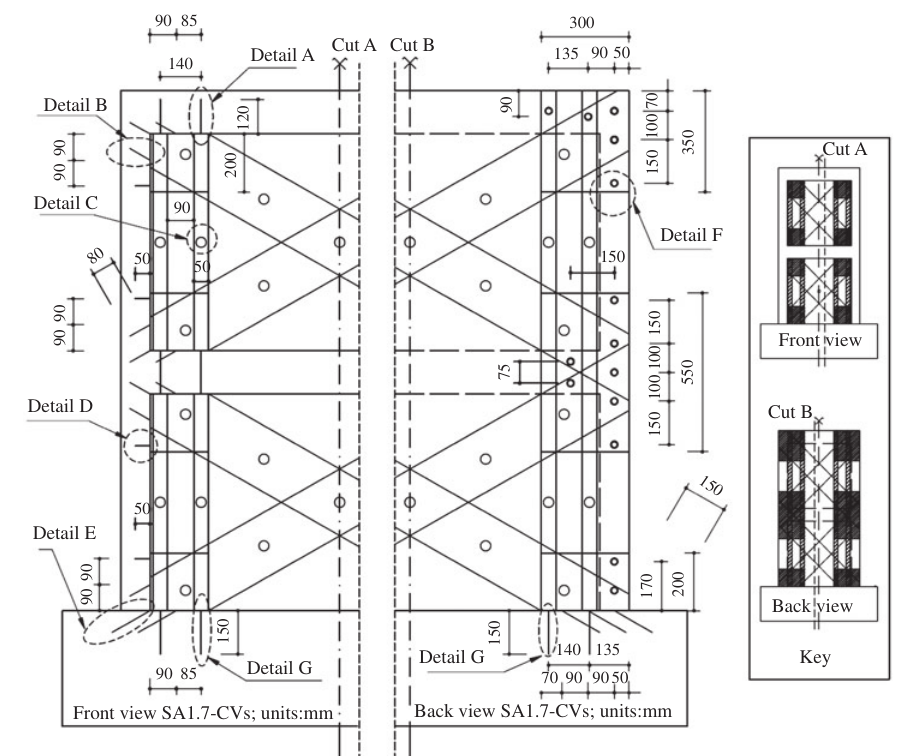
Figure 3 Strengthening details of specimen SA1.7-CVs.